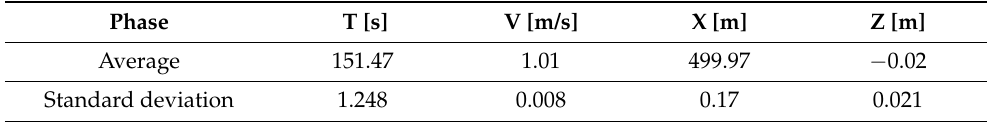
Table 14. Statistic elements of the landing position in case 2.